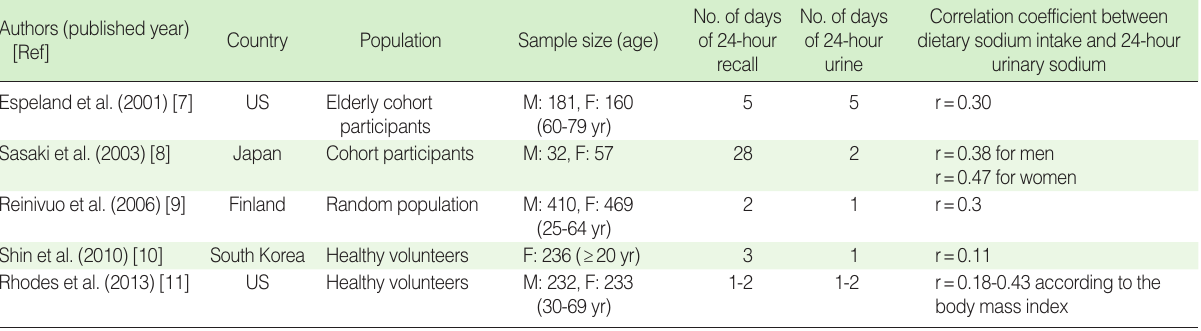
Table 1. Studies that compared the 24-hour dietary recall method with the 24-hour urine collection method for the estimation of sodium in- take in a healthy